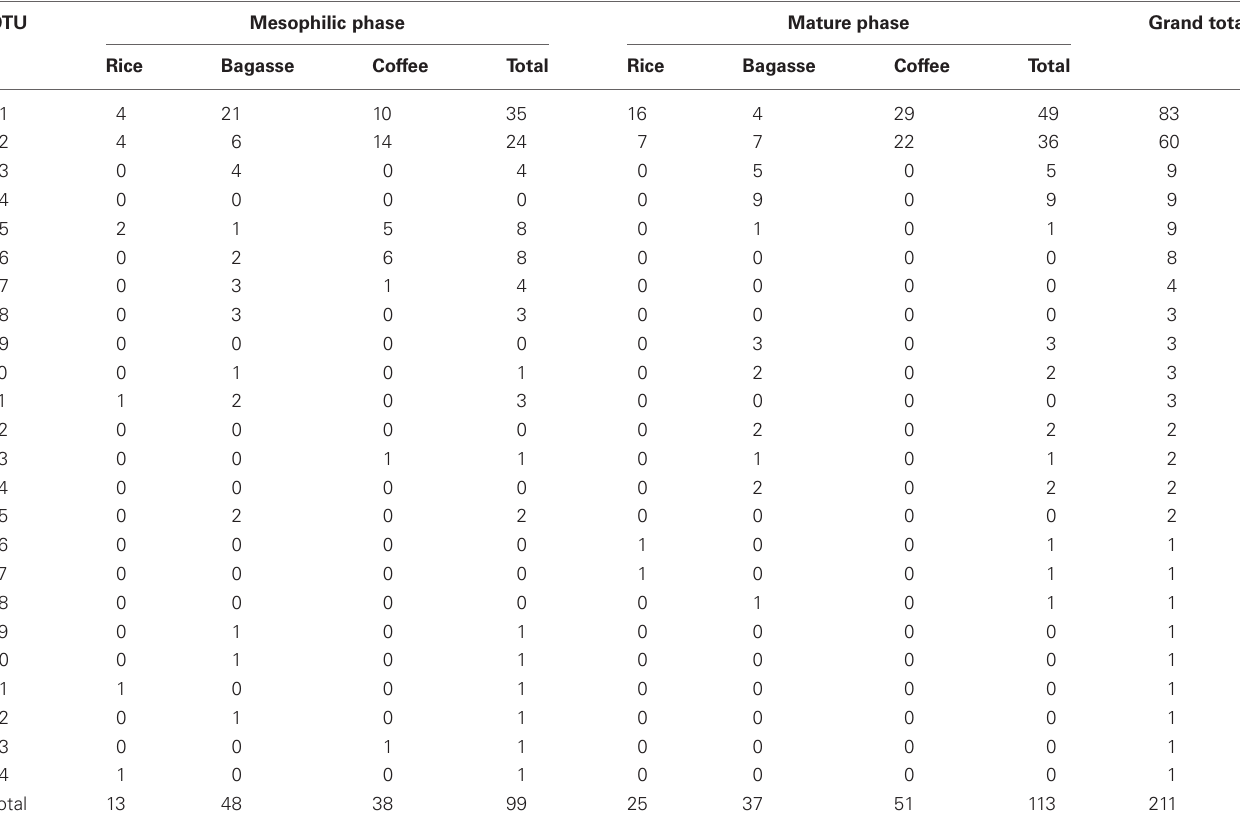
Table A2 | Distribution of OTU by compost phase and treatment.